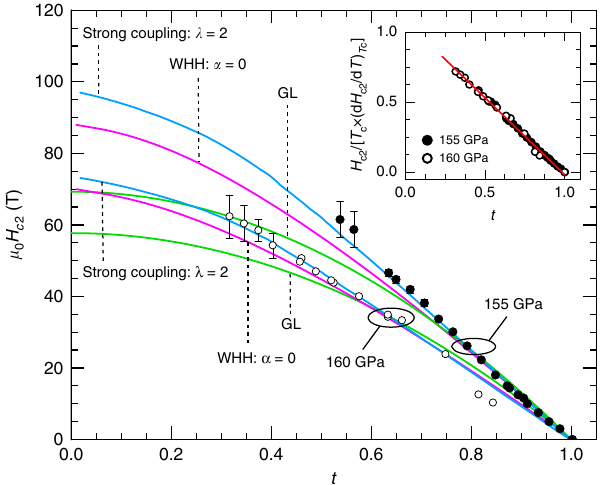
Fig. 4 Superconducting phase diagram of H 3 S. Upper critical fi elds H c2 as a function of the reduced temperature t = T / T c for the H 3 S samples under pressures p = 155 GPa ( fi lled circles) and 160 GPa (open circles). Solid lines are fi ts to theoretical models: Ginzburg-Landau (GL), Werthamer,